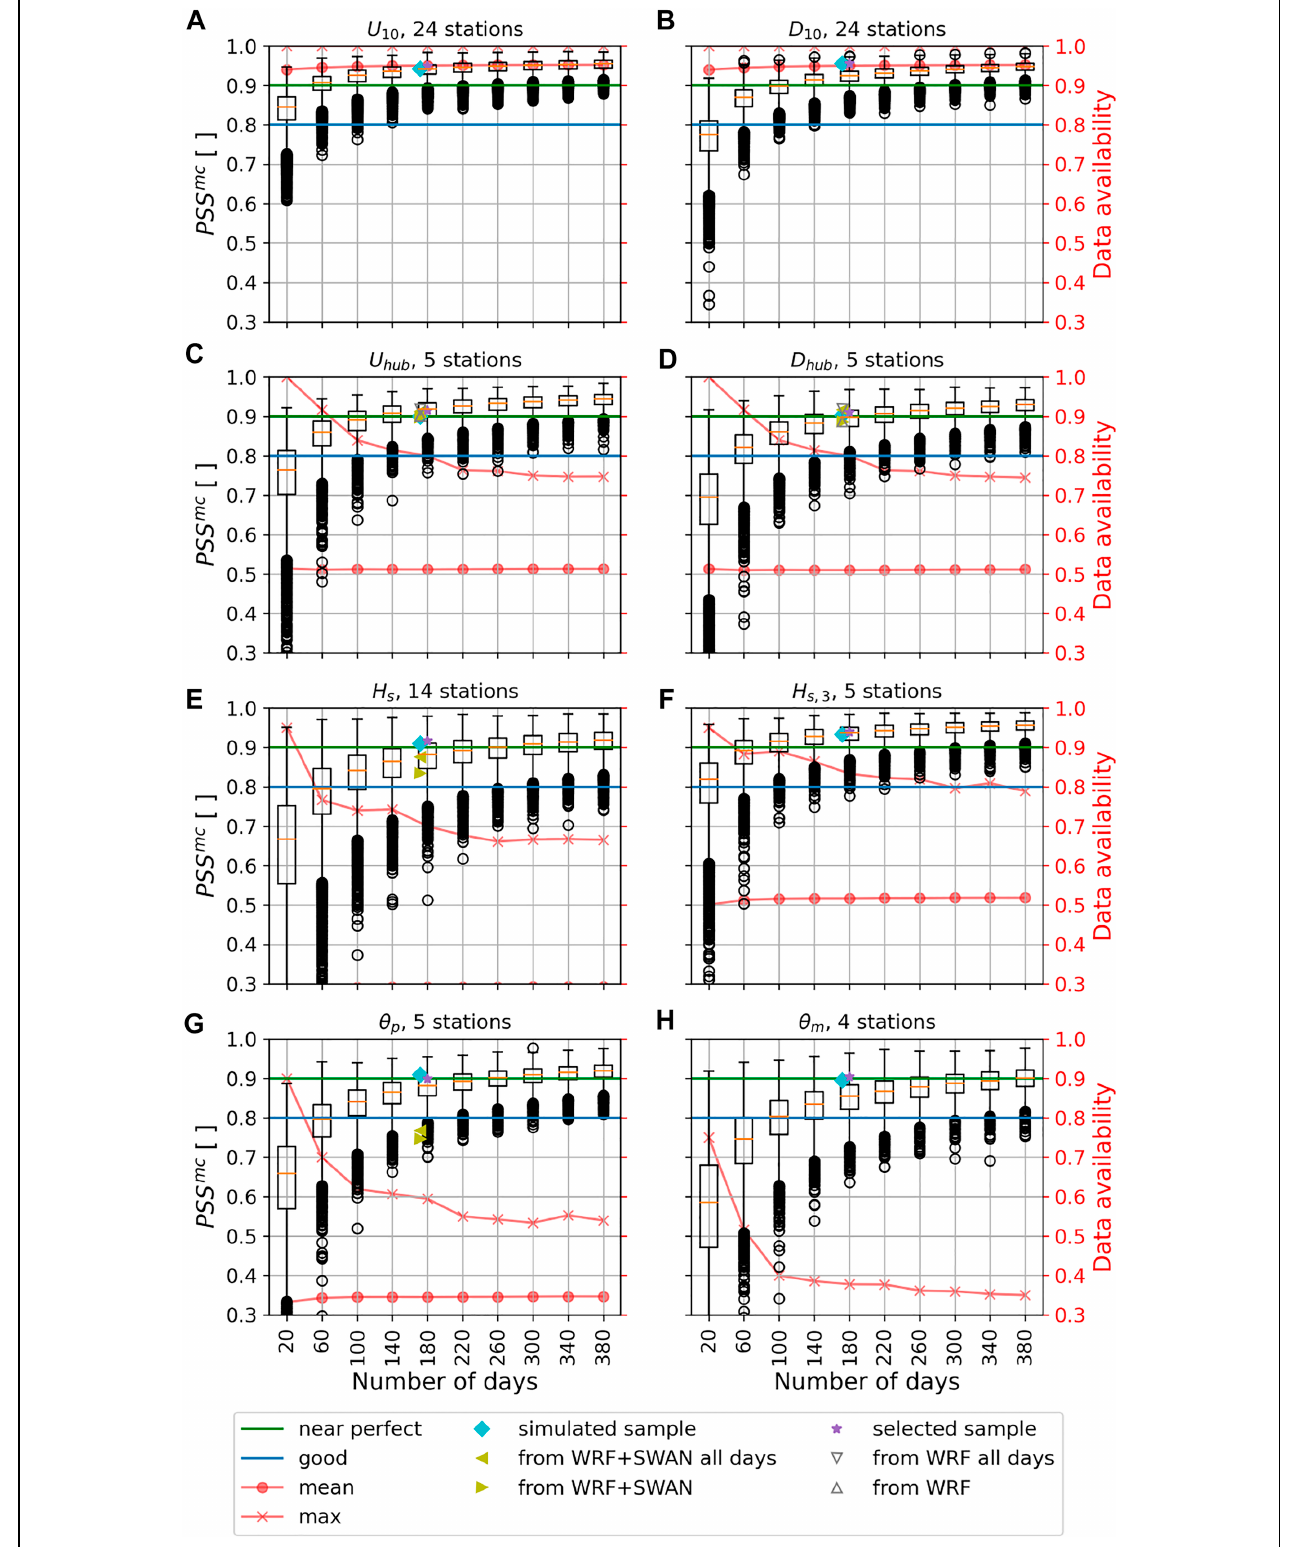
FIGURE 4 | Same as Figure 3 , but for PSS mc for (A,B) near surface wind speed and direction (C,D) hub-height wind speed and direction (E,F) significant wave height for one and 3 hour resolution and (G,H) peak and mean wave direction. Mean availability for θ m is below 0.3 and thus not visible in (h).